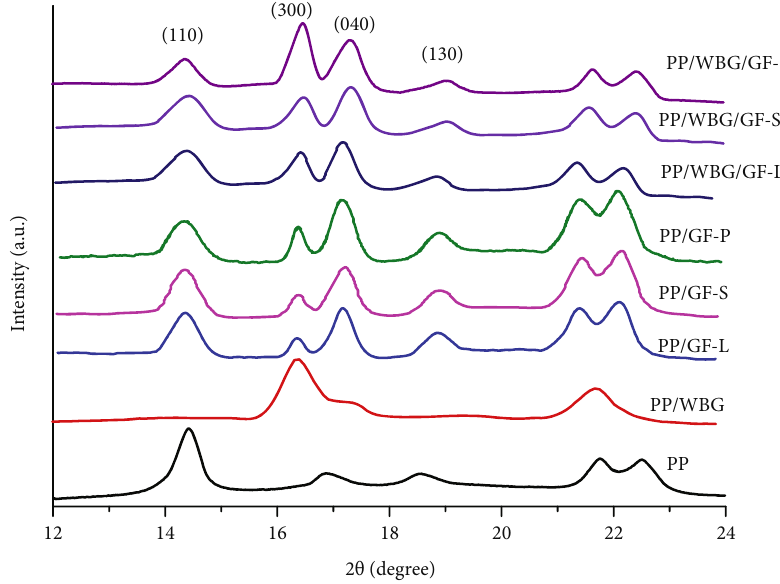
Figure 2: XRD di ff raction patterns of